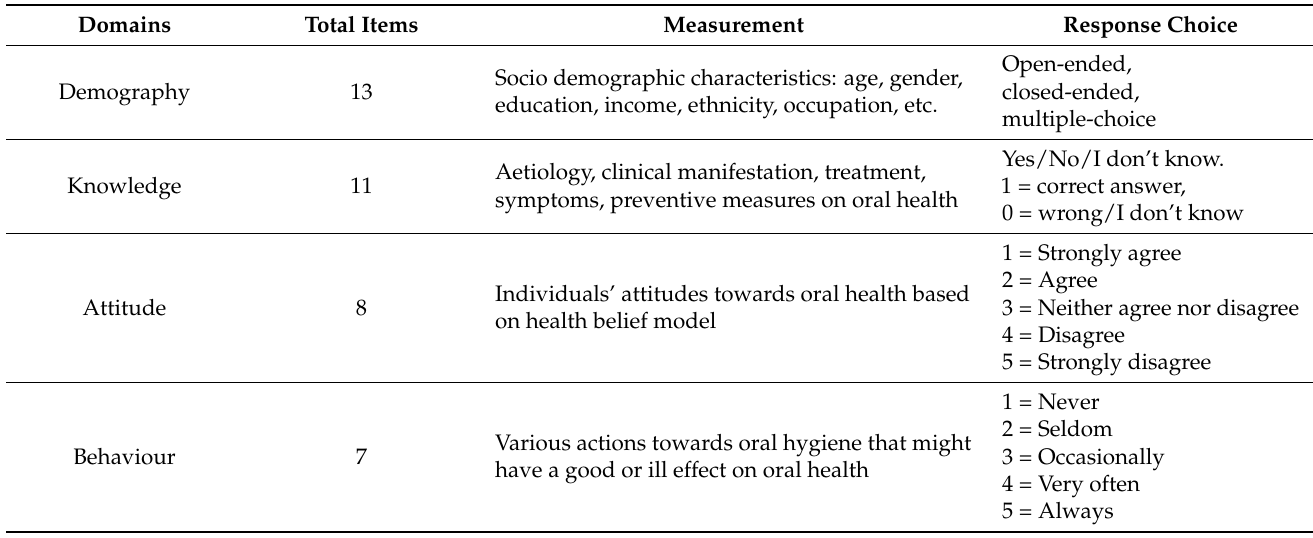
Table 1. Response Choice of KAB Questionnaire towards Oral Health.